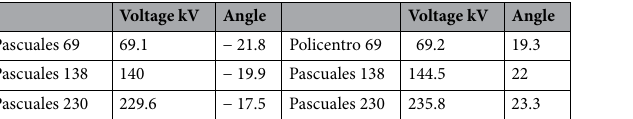
Table 4. Magnitude and angle variation before (left) and after (right) entering Pascuales static load model.